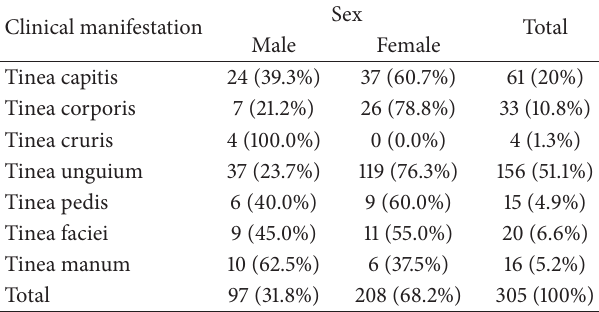
Table 1: Frequency and percentage distributions of clinical mani- festations in relation to sex ( 𝑛 =